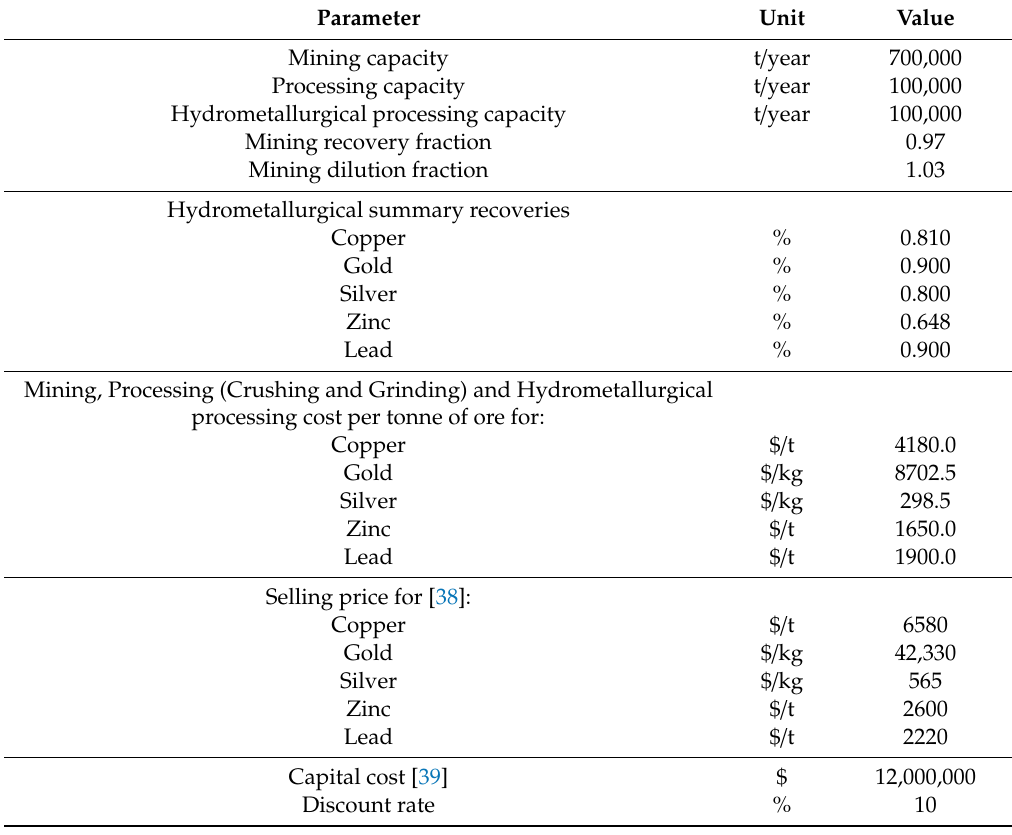
Table A1. Techno-economic parameters for economic